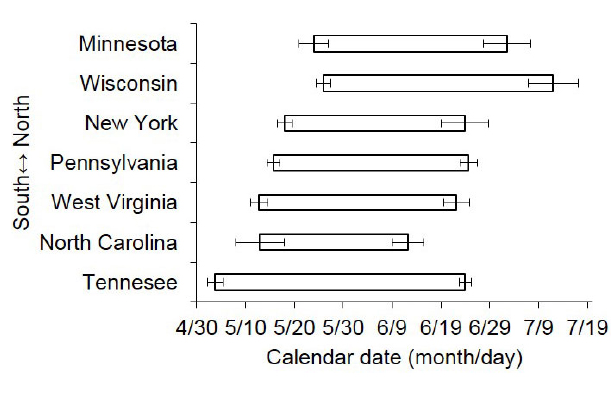
substantial support ( Δ QAIC = 1.85) but was less plausible ( w = c i 0.28, Table 3). However, the beta coefficient 95% CIs overlapped zero for the linear and quadratic relationships between time- within-season and DSR (Table 4), suggesting low biological importance of time-within-season on DSR. Fig. 2 . Mean (± SE) annual Golden-winged Warbler ( Vermivora chrysoptera ) first egg dates (left end of bar) and last nest active dates (right end of bar). The timing of the nesting season was delayed as state latitude increased. Where available, we obtained data to fill gaps among years for Minnesota (2011-2012, H. M. Streby, unpublished data ) and North Carolina (2012, C. G. Smalling, unpublished data ); these nests were not included in our other analyses because they were not sampled using our standardized